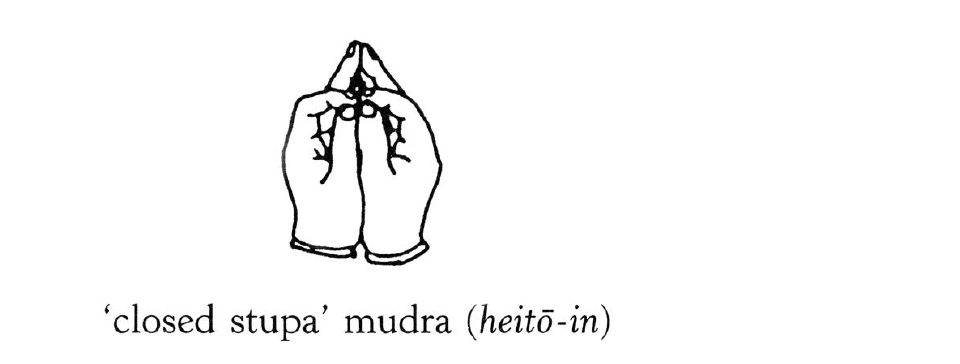
Figure 4. Heit¯o-in mudra. Reproduced from Inaya Y¯usen, Shingon Shint¯o sh¯usei ; Seizansha, 1993. Figure 4. Heitō - in mudra. Reproduced from Inaya Yūsen, Shingon Shintō shūsei ; Seizansha, 1993. woodblock print showing Kong¯osh¯oji’s Uh¯o D¯oji with the seed syllable of Dainichi of (Figure 5).